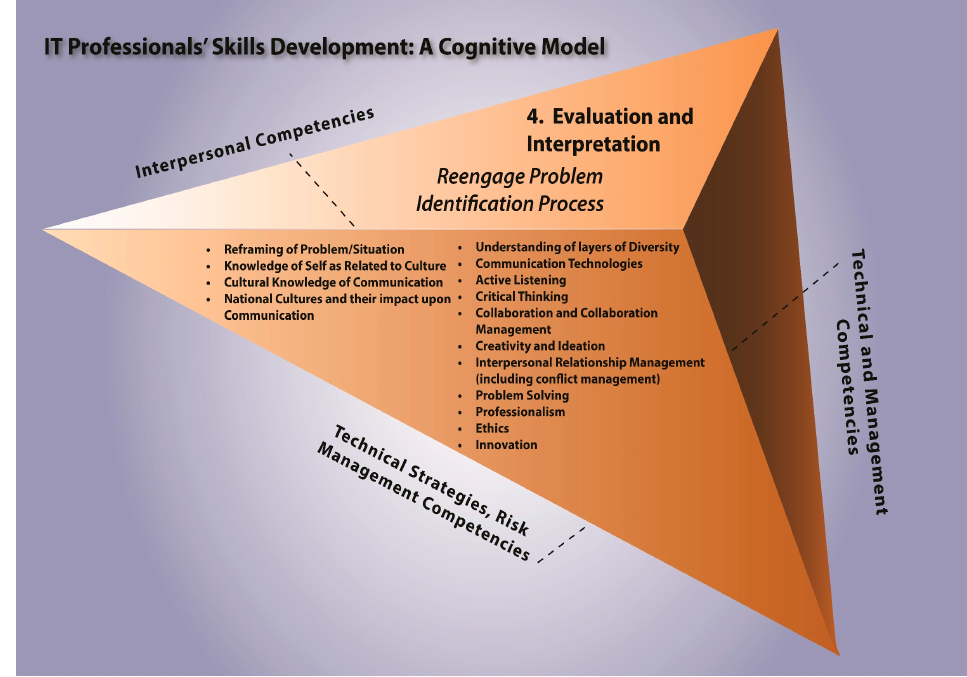
Figure 5. Illustration of the Necessary Non-technical Skills for Step 4: Evaluation and Interpretation : Re-engagement of the Problem Identification Process within the IT Project Systems Development Life Cycle Context.